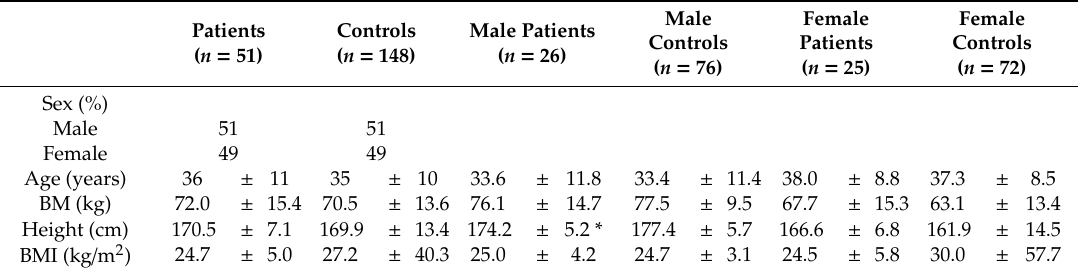
Table 2. Anthropometric and descriptive data by group and sex.